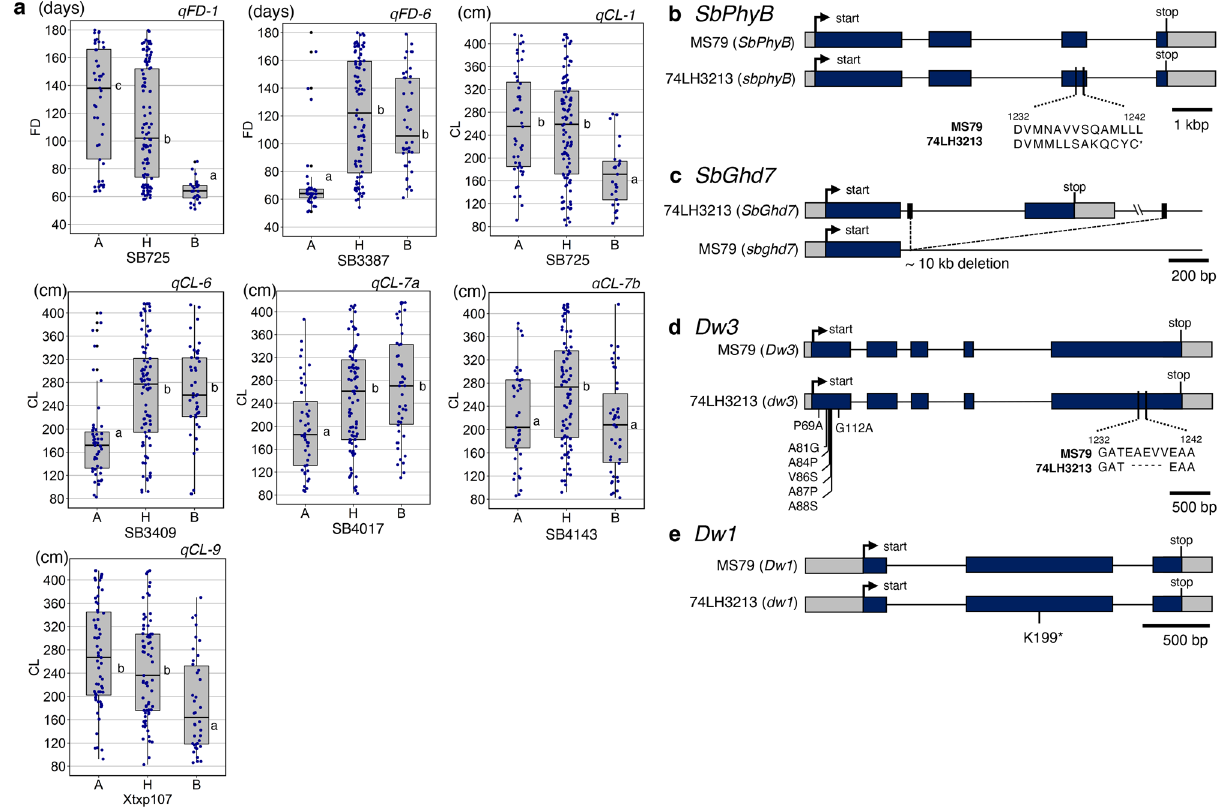
Figure 2. Allelic effects for FD and CL in the F 2 population, and the candidate corresponding genes for the QTLs. ( a ) Allelic effects of FD and CL in the F 2 population, as determined from the nearest markers of the identified QTLs. Each plotted point indicates an individual plant in the F 2 population. A, H, and B on the x -axis indicate the homozygous MS79 allele, the heterozygous MS79/74LH3213 allele, and the homozygous 74LH3213 allele, respectively. Only the data from 2015 are shown as a representative sample. ( b – e ) Exons and introns are indicated with boxes and black lines, respectively. The dark blue boxes indicate protein coding sequences; the grey boxes indicate untranslated regions (UTR). The alleles in SbPhyB ( b ), SbGhd7 , ( c ), Dw3 ( d ), and Dw1 ( e ) are